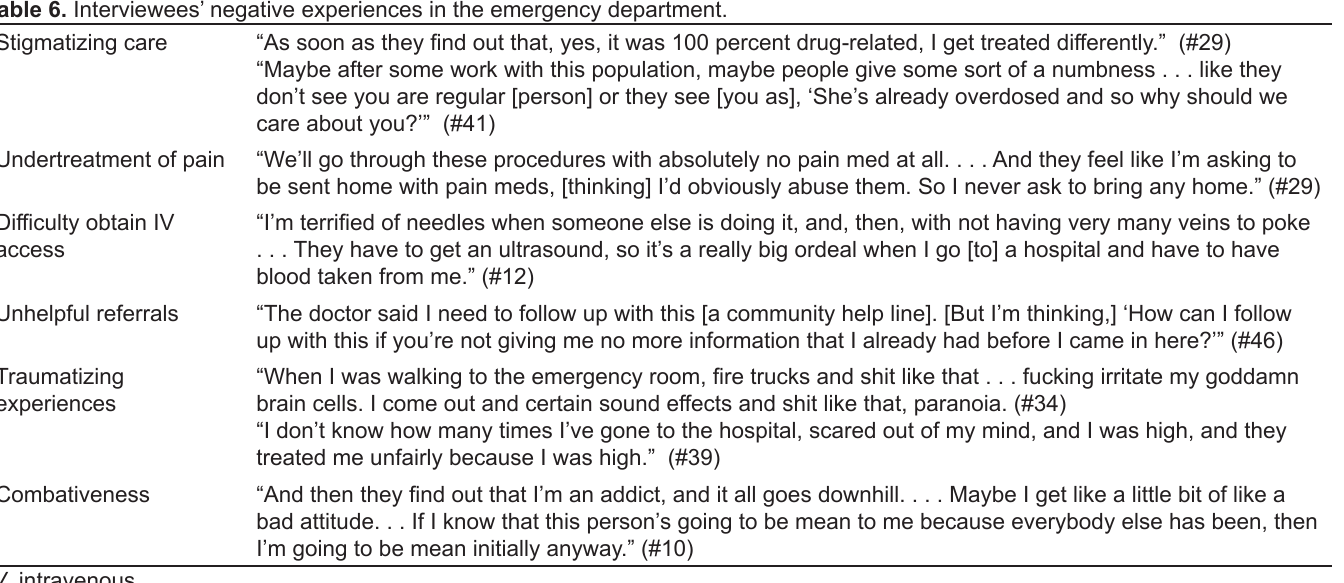
Table 6. Interviewees’ negative experiences in the emergency department.